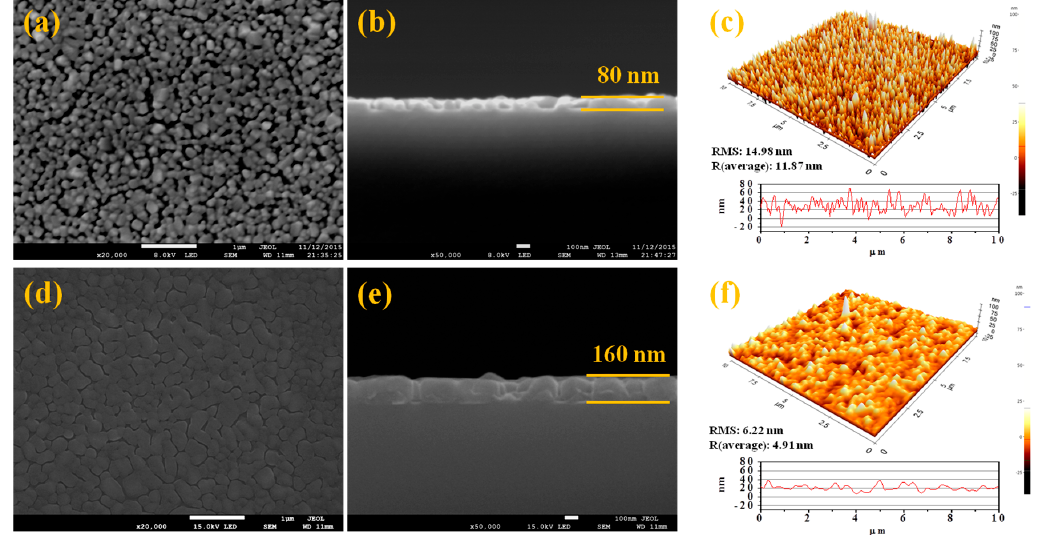
Figure 1. SEM and AFM images of VO 2 ( a – c ) and SiO 2 /VO 2 ( d – f ) thin films. The average roughness of the samples was ( c ): 11.87 nm and ( f ): 4.91